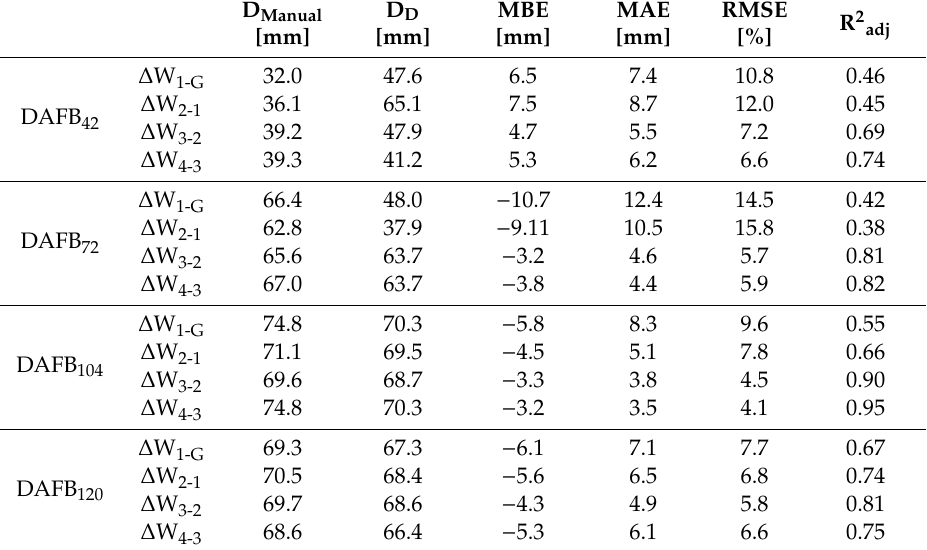
Table 1. Results of manually measured mean diameter (D Manual ) [mm] and the mean